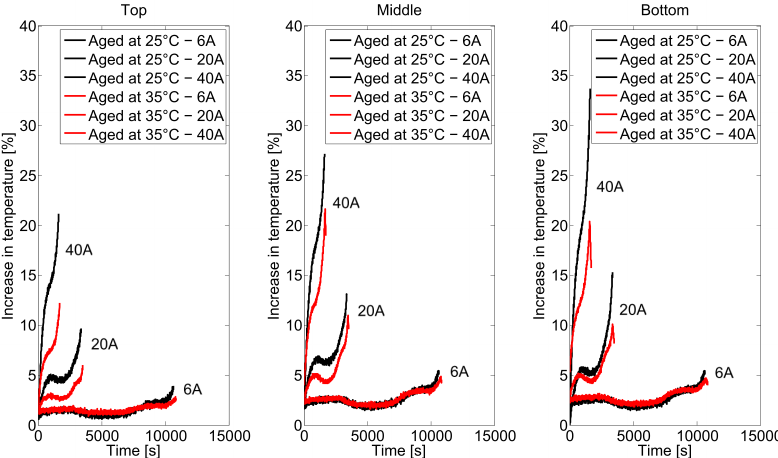
Figure 12. Temperature increase of the cell 2 at 25 ◦ C and 35 ◦ C under various current